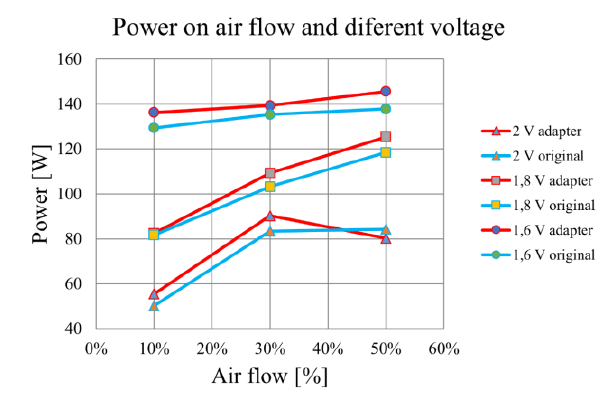
Fig. 7. Effect of air flow and fuel cell voltage on fuel cell performance